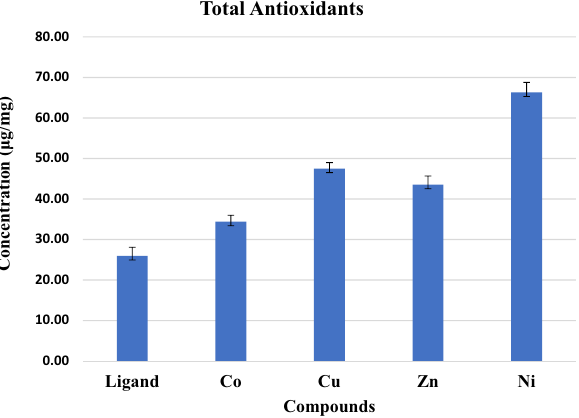
Figure 12. Total antioxidant concentration (μg/mg) for the ligand and its metal